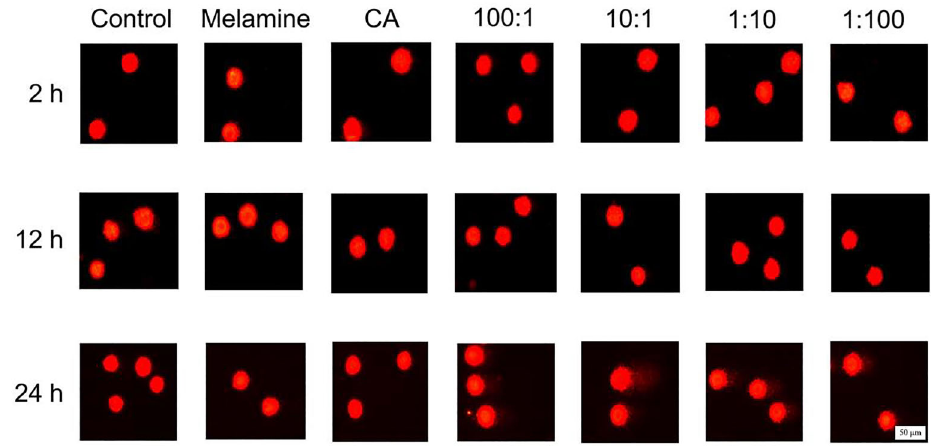
Figure 4. Alkaline comet assay of 293 cells treated with melamine, cyanuric acid (CA), or various ratios of melamine-CA. Representative images of cells at different time-points are shown. Scale bar: 50 m m.